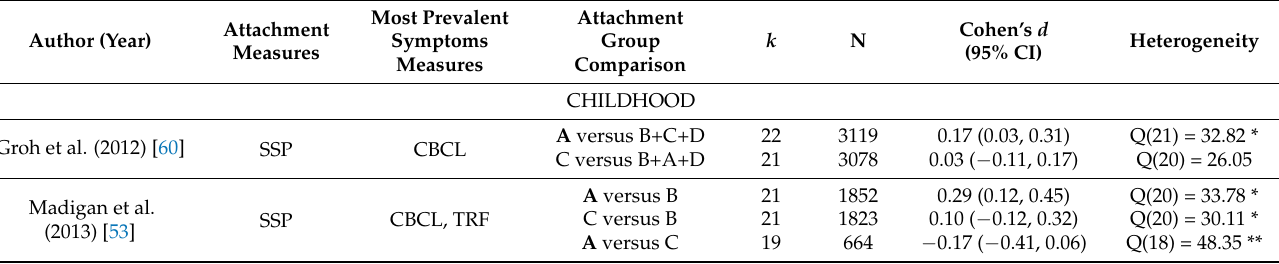
Table 1. List of meta-analyses assessing the magnitude of the links between insecure attachment patterns and internalizing